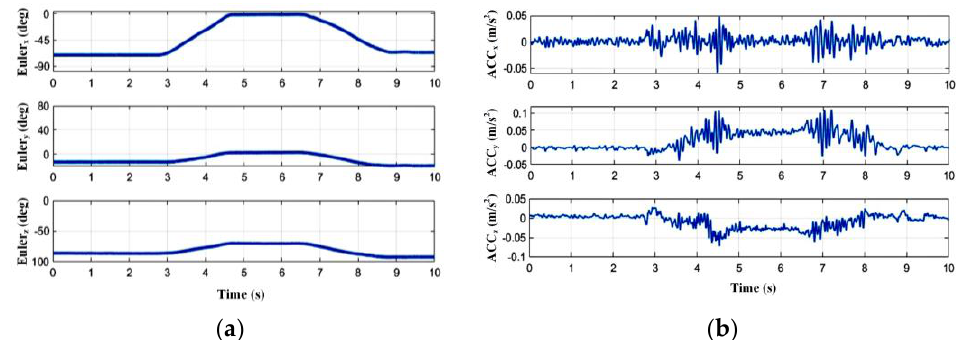
Figure 2. The IMU data during elbow dynamic flexion/extension with low strength: ( a ) three − axis euler angles; ( b ) three-axis accelerations. euler angles; ( b ) three-axis